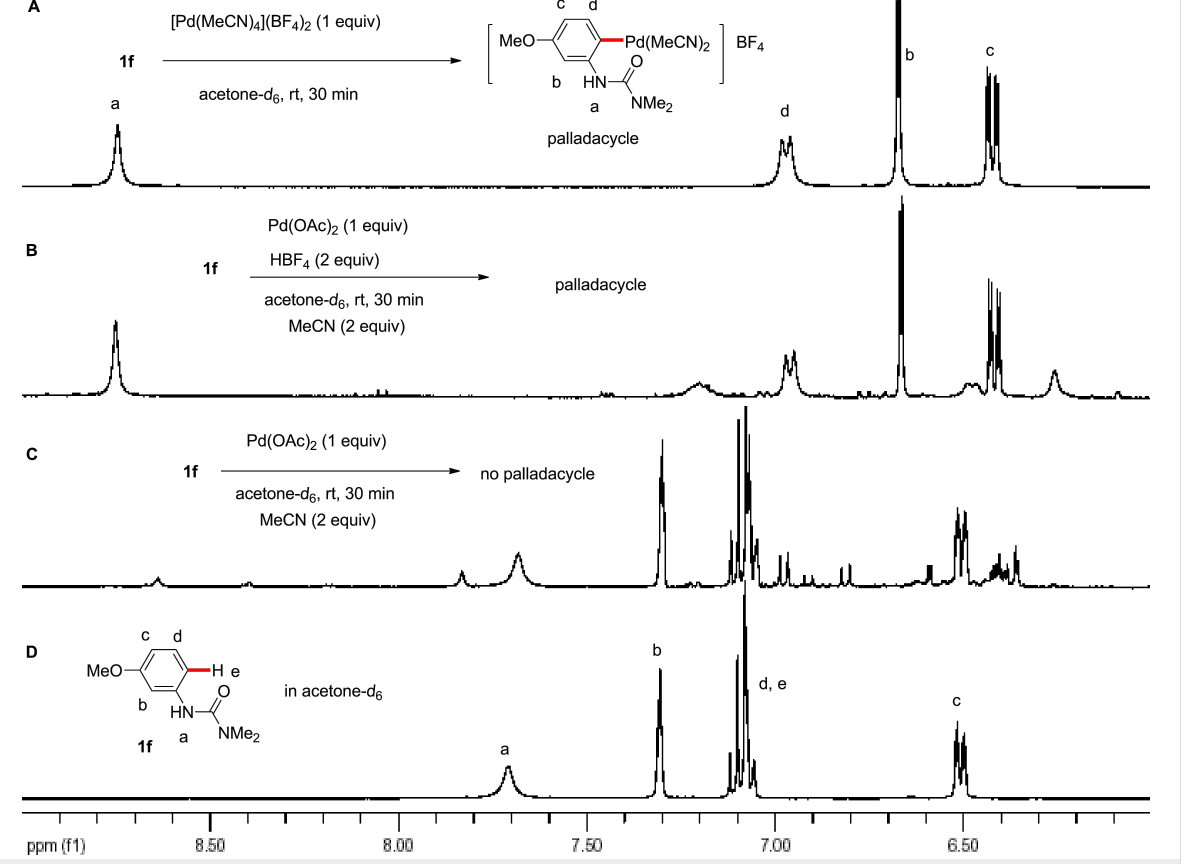
Figure 8: NMR studies. A: The reaction of [Pd(MeCN) 4 ](BF 4 ) 2 and 3-MeOC 6 H 4 NHCONMe 2 in acetone- d 6 . B: The reaction of Pd(OAc) 2 and 3-MeOC 6 H 4 NHCONMe 2 in the presence of HBF 4 and MeCN in acetone- d 6 . C: The reaction of Pd(OAc) 2 and 3-MeOC 6 H 4 NHCONMe 2 in the pres- ence of MeCN in acetone- d 6 . D: 3-MeOC 6 H 4 NHCONMe 2 in acetone- d 6